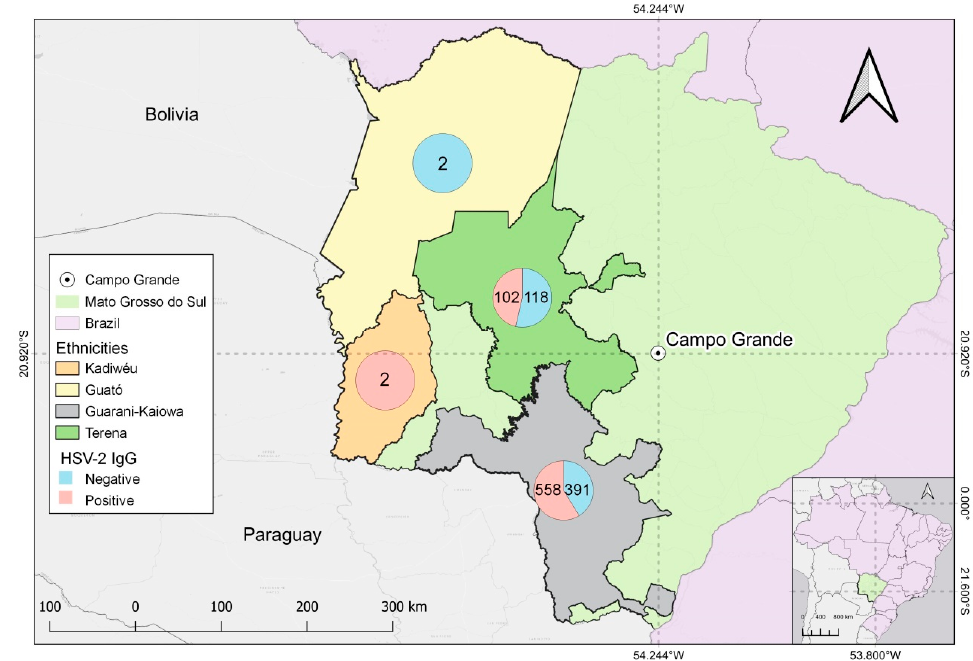
Figure 3. Positive and negative outcomes for anti-HSV-2 IgG serological test among Indigenous Guarani-Kaiowá, Kadiwéu, Guató, and Terena ethnicities and their geographical locations in Mato Grosso do Sul, Brazil. Table 2. Relationship between HSV-2 prevalence, ethnicity, socioeconomic, and education vari- ables in Indigenous populations of Boror ó and Jaguapir ú villages (Dourados, Mato Grosso do Sul (MS),